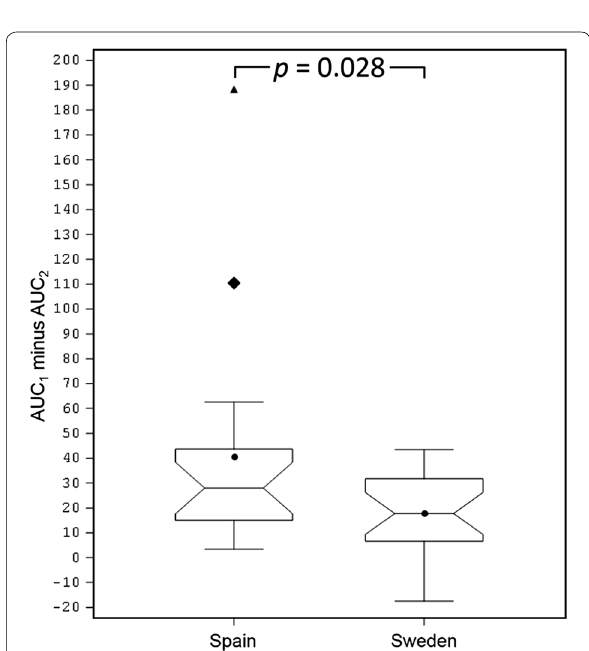
Fig. 5 AUC 1 minus AUC 2 by country. AUC 1 is the area under the inhibition curve obtained after competition of increasing dilutions of one 5-grass tablet for the binding of serum IgE from Spanish and Swedish patients ( n 19 and 22, respectively) to immobilized = allergens of a 12-grass pollen extract, and detection of the IgE that remained bound to the immobilized allergens; AUC 2 is the area under the inhibition curve obtained in the same conditions with increasing dilutions of three 1-grass pollen tablets. The triangle and losange are, respectively, a severe outlier and an outlier corresponding to Spanish patients #00103 and #00118. The p -value was obtained with the exact two-sided Wilcoxon rank-sum